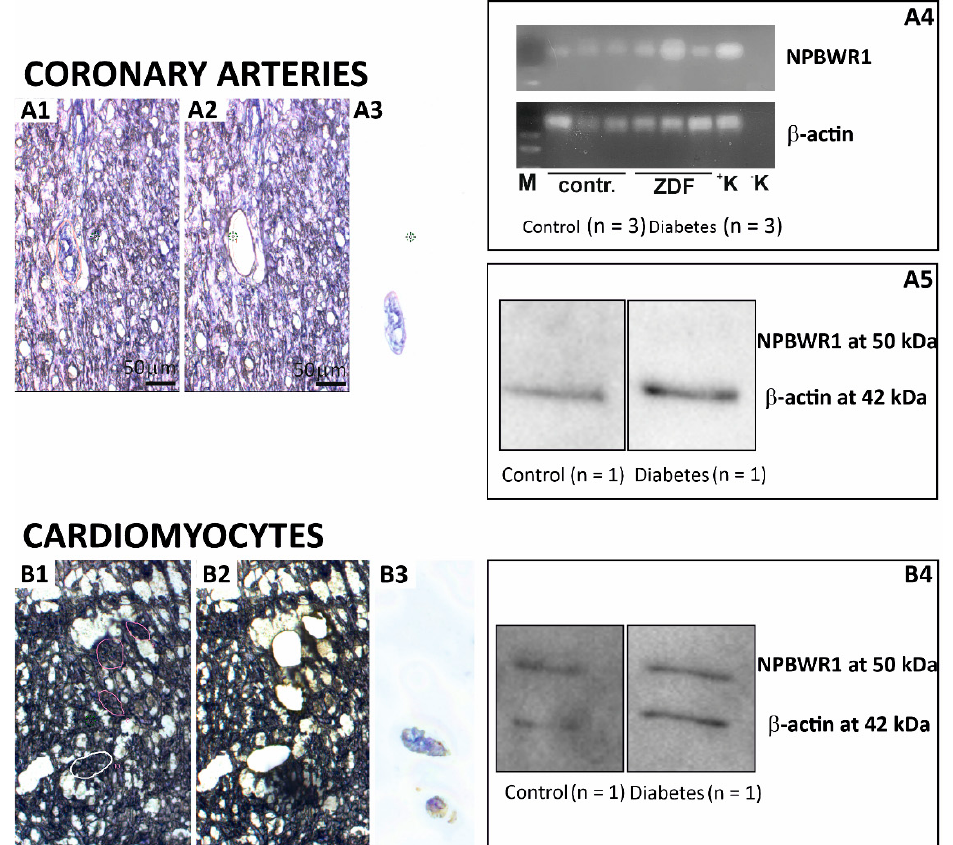
Figure 2. LCM dissection of coronary arteries ( A1 - A4 ) and cardiomyocytes ( B1-B4 ) from the left ventricle of the rat heart: Hematoxylin-stained heart tissue of 13 µm thickness on laser microscope at 20× resolution. Appropriate areas were marked for cutting through the laser within sections ( A1 , B1 ). Tissue sections after precise laser cutting and collecting the cut pieces ( A2 , B2 ). Captured pieces collected on the lid of microtubes ( A3 , B3 ). PCR analysis of the LCM section: detection of expression of β -actin and NPBWR1 genes ( A4 ). Western blot analysis of the LCM section (0.5 mm²/lane) with anti-NPBWR1 (1:2000) and anti-ACTB (1:250); an immunogenic band of ACTB at 42 kDa was identified in smooth muscles of LV ( A5 ); immunogenic bands of ACTB at 42 kDa and NPBWR1 at 50 kDa were identified in cardiomyocytes of LV ( B4 ).